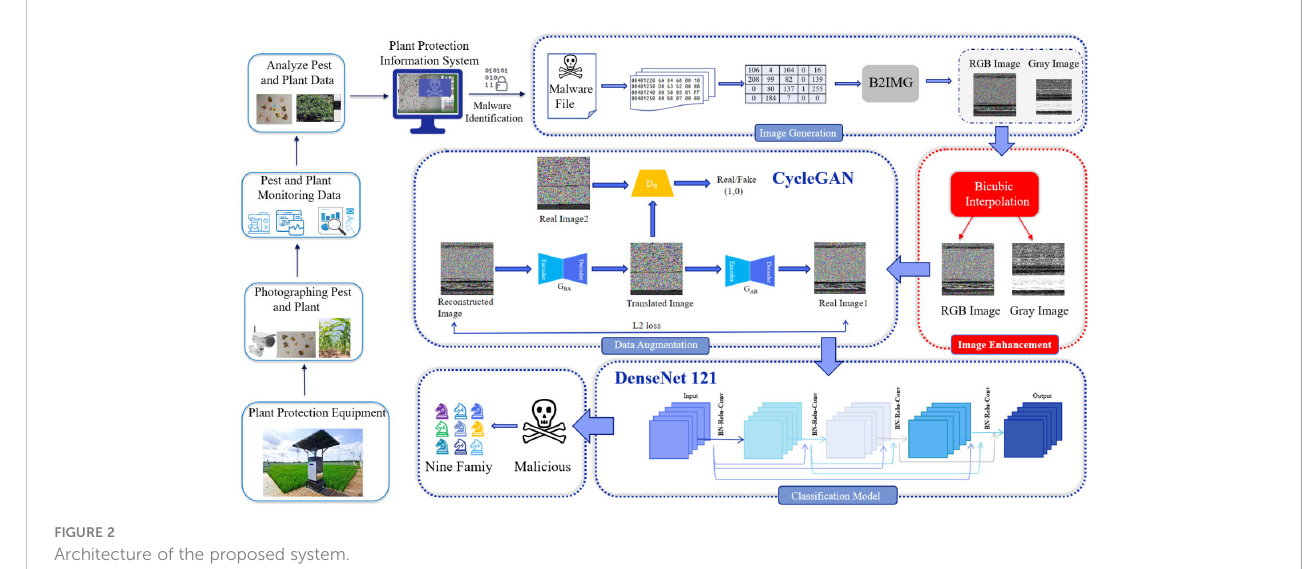
FIGURE 2 Architecture of the proposed system.